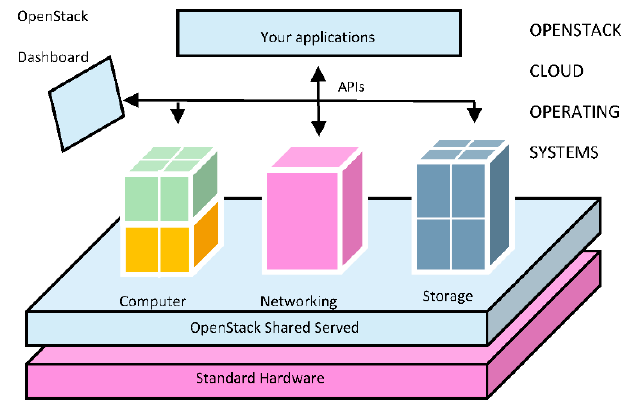
Figure 2. OpenStack Cloud Computing Operating System.